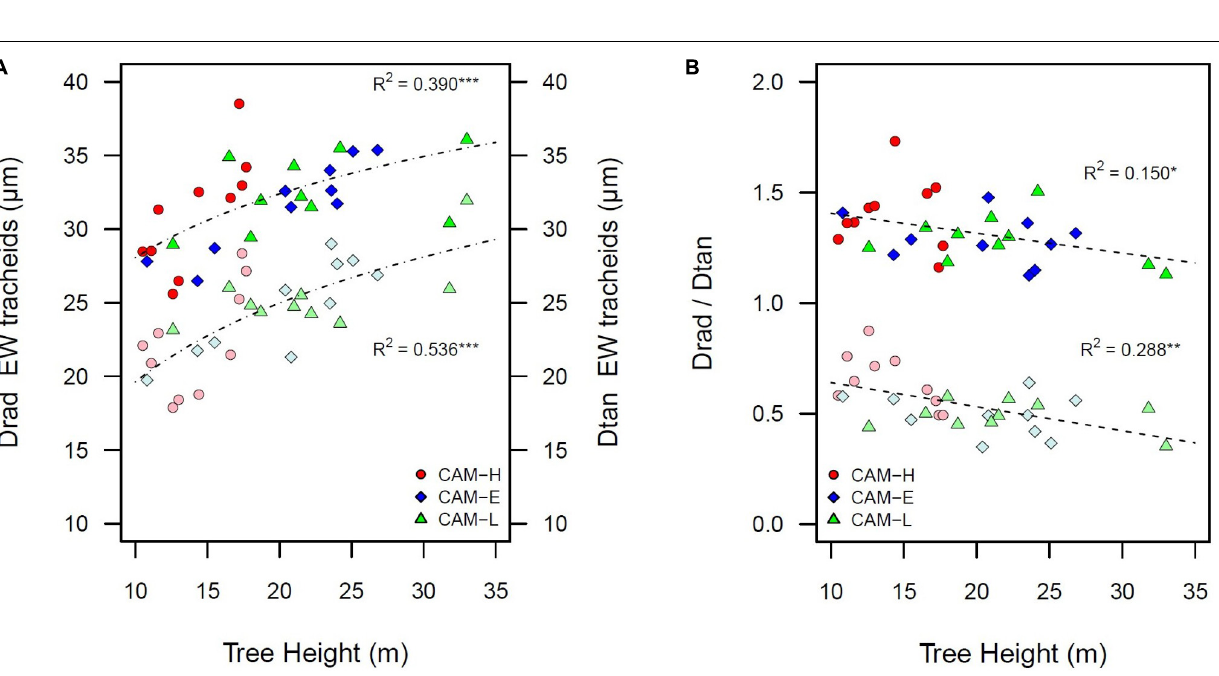
Frontiers in Plant Science |